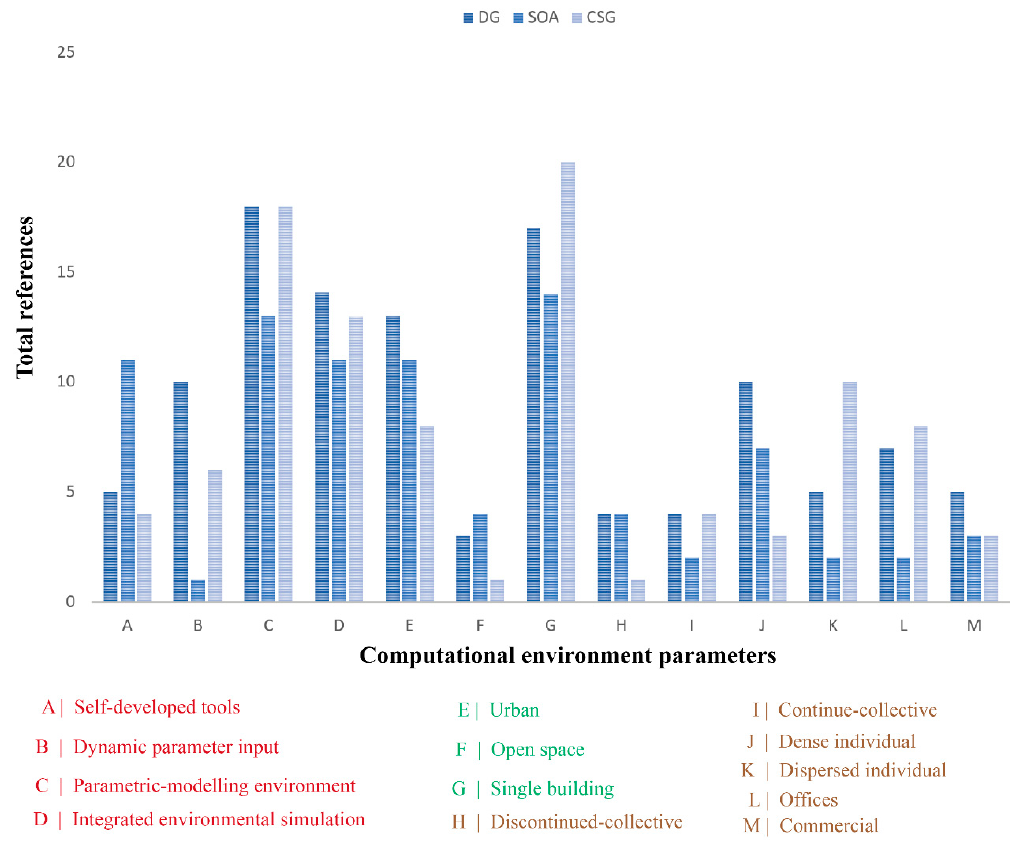
Figure 5. Distribution of computational environment parameters according to the corresponding computational computational methods.